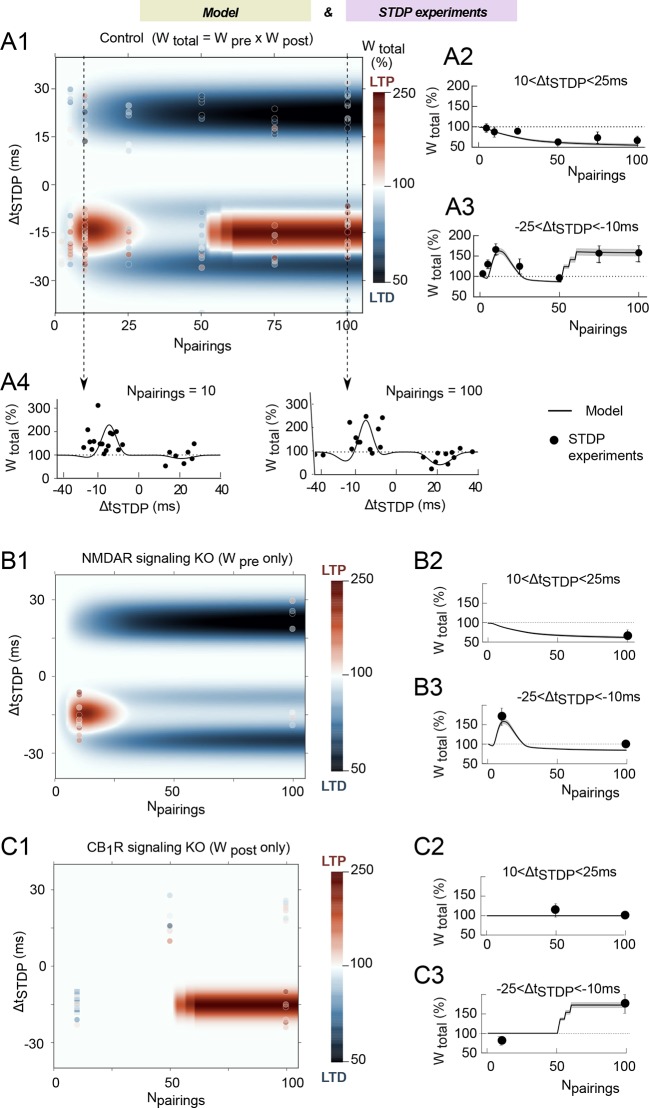
The mathematical model matches the experimental data.(A) Changes of the total synaptic weight
Wtotal (LTP and LTD) when
Npairings and ΔtSTDP vary.
(A1) Color-coded changes of
Wtotal in the (Npairings,
ΔtSTDP) space. The color bar indicates the color code. The
background map shows the simulation results whereas the color-coded
points (same color-code as the simulations) are experimental results. The
average changes with Npairings of
Wtotal integrated over short positive or
short negative ΔtSTDP are shown in (A2) and
(A3), respectively. Cross-sections of the two-dimensional
map (A1) along the N-axis are shown as
changes of Wtotal with ΔtSTDP, for
Npairings=10 (A4) or 100
(A5) pairings at 1 Hz. In (A2-A5), full
black lines represent the simulation results whereas the full black
circles show experimental results. (B,C) Corresponding
results obtained with variants of the mathematical model where
NMDAR-signaling (B) or eCB-signaling (C) were
knocked-out in silico. The 2D maps (B1, C1) use the same
color code and symbols as (A1). The average changes of
Wtotal over short positive or short
negative spike timings ΔtSTDP (B2,C2) and
(B3,C3), respectively, use the same symbols as
(A1-2).